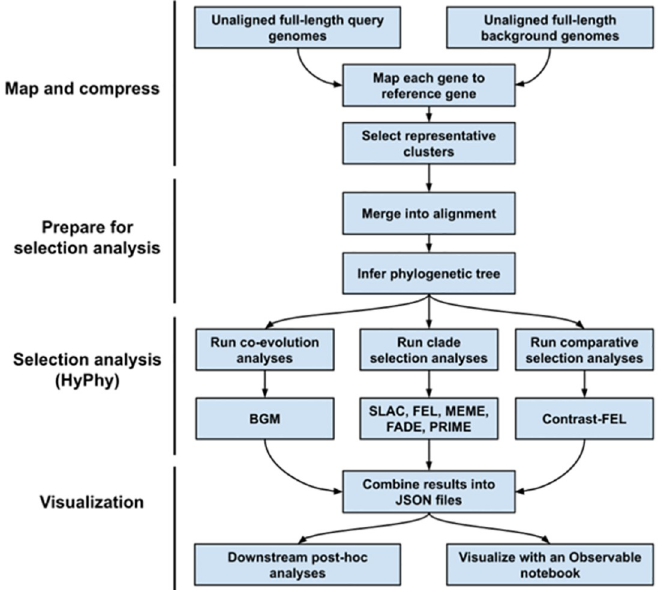
Fig 1. The RASCL application overview. We highlight the high-level architecture of the RASCL workflow. These include what we call multiple Phases, including a (1) Map and Compress step, where input query and background whole genome sequences are separated into individual genes from the viral genome by mapping to the reference gene. For each gene we then extract the representative gene diversity using genetic distance clustering. (2) is where we prepare our gene alignments for selection analysis. We accomplish this by merging alignments from the background and query datasets into a “combined” dataset. From this, we infer a phylogenetic tree and annotate it based on query and background sequences. (3) We perform selection analyses in HyPhy (described in further detail in the Methods section). (4) We combine the results of selection analyses across the viral genome by mapping substitutions to each position in the viral genome to create a selection ‘profile’ for each statistically significant site into an interpretable JSON-formatted file. These combined results are then used for further post-hoc or downstream analysis or ingested by our interactive